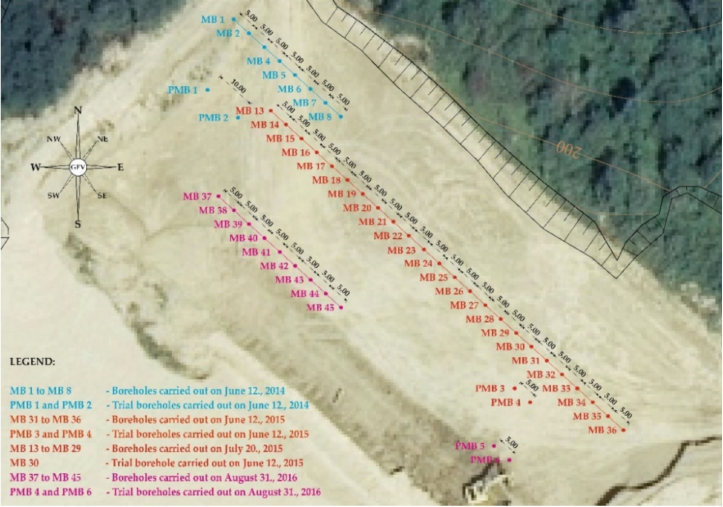
Figure 2. Training area on exploitation field Cukavec II [2].